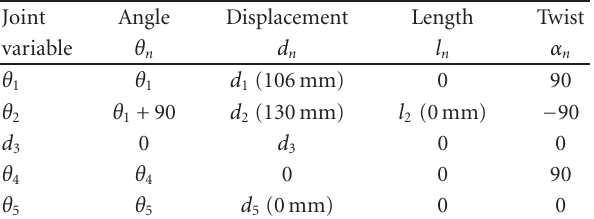
Figure 3: IEEE-754 format. Table 1: Denavit-Hartenberg parameter of robot